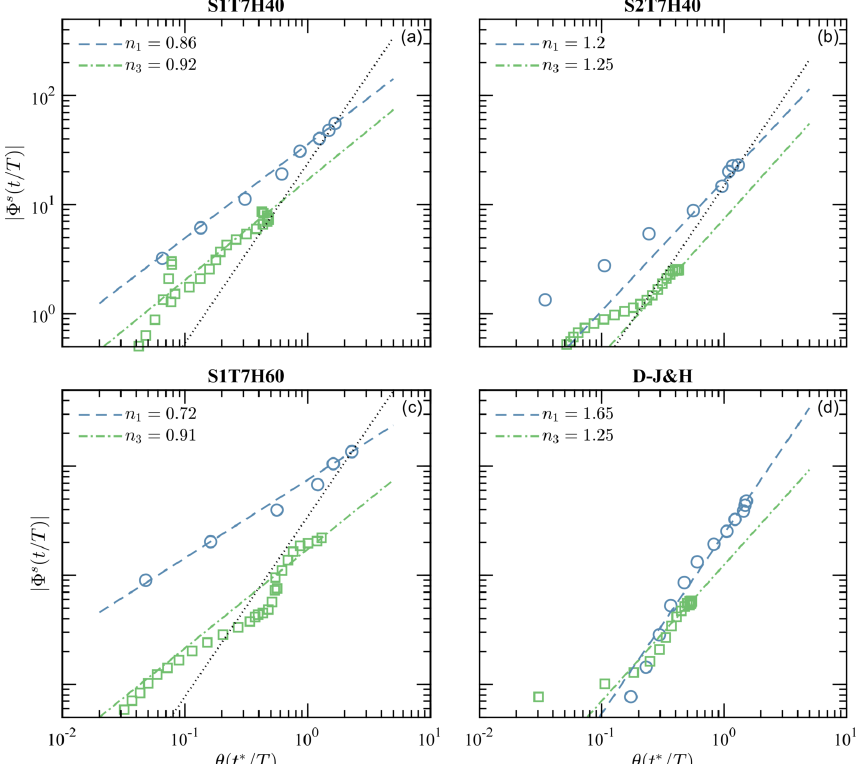
Figure 13. The relationship between non-dimensionalized total sediment transport rate, Φ s ( t / T ) , and the phase-shifted Shields parameter, θ ( t ∗ / T ) , during the T 1 (blue circles) and T 3 (green squares) phases for ( a ) S1T7H40, ( b ) S2T7H40, ( c ) S1T7H60 [46], and ( d ) D-J&H [43]. Blue dashed and green dash–dot lines represent the best-fit n 1 and n 3 , respectively. Dotted lines denote n = 1.65. Dohmen-Janssen et al. [36] introduced a phase-lag parameter, Pl , to incorporate unsteadiness effects. A semi-unsteady model was developed to include the phase-lag effect on the net, i.e., wave-averaged, sediment transport rate [36]. van der A et al. [38] expanded the phase-lag parameter based on the half wave-cycle concept [39] to